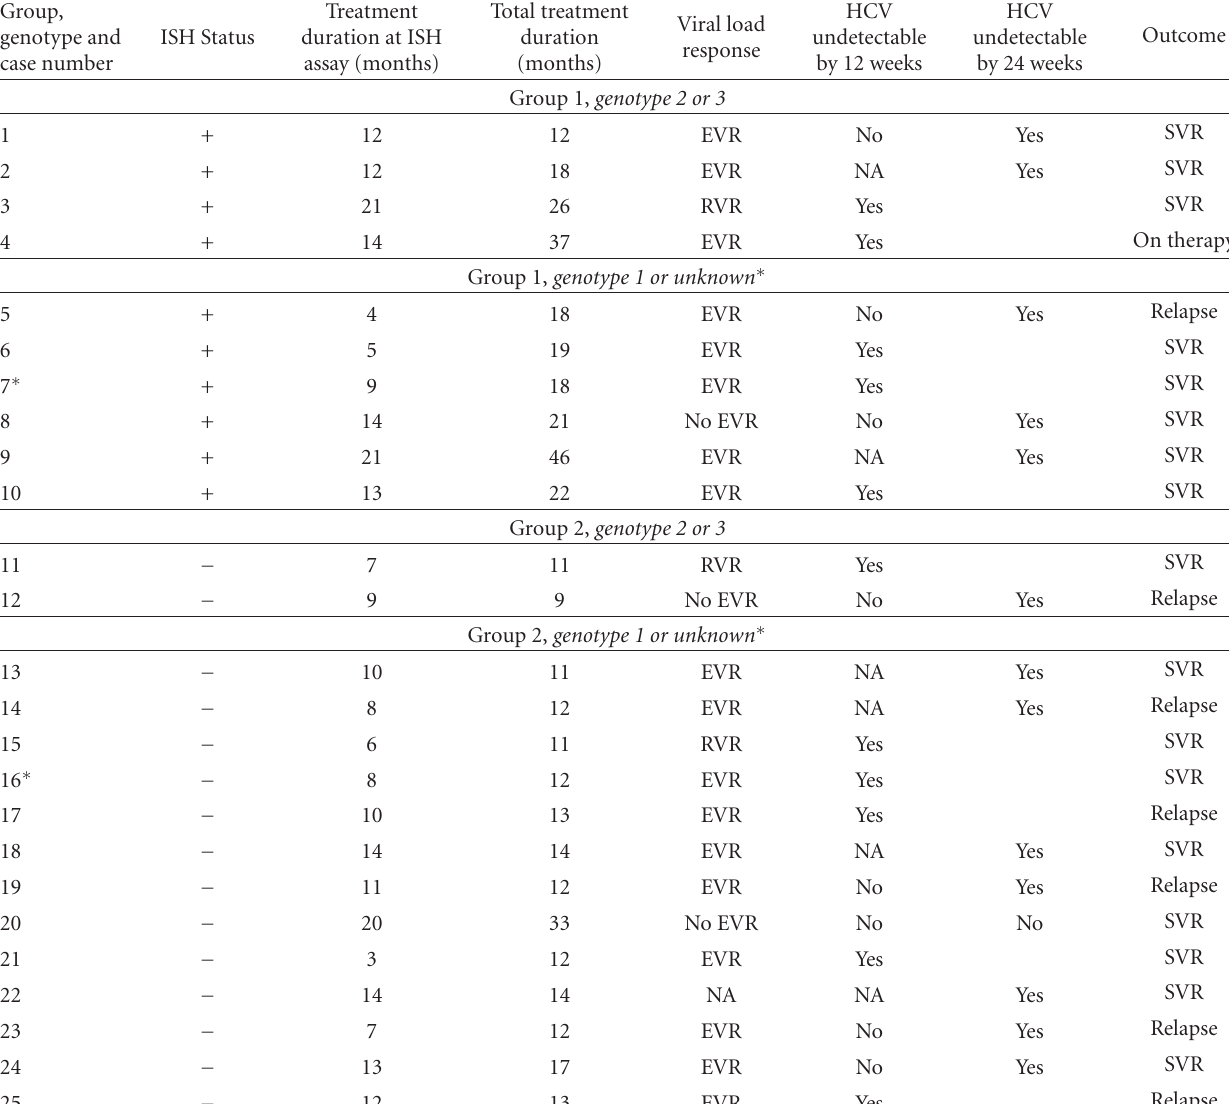
Table 3: Antiviral treatment duration and outcomes collated by patient group, HCV genotype, timing of ISH assayed biopsy and virologic response.